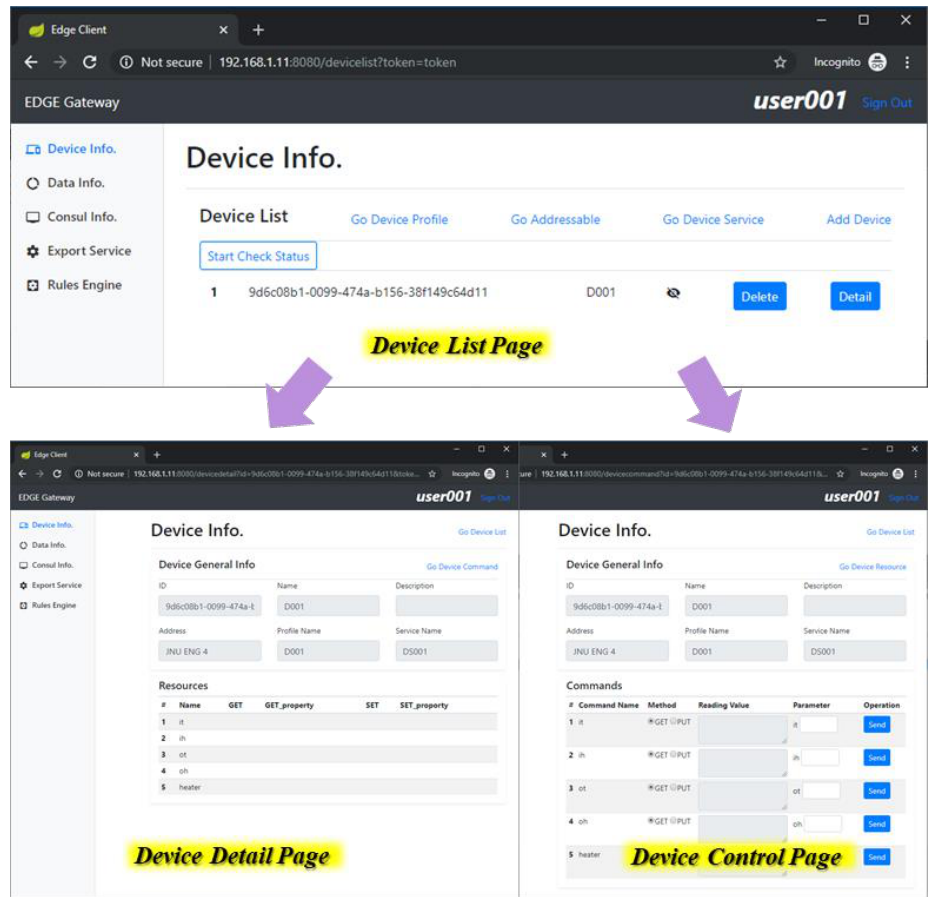
Figure 12. Presentation of the IoT device information on the edge client.